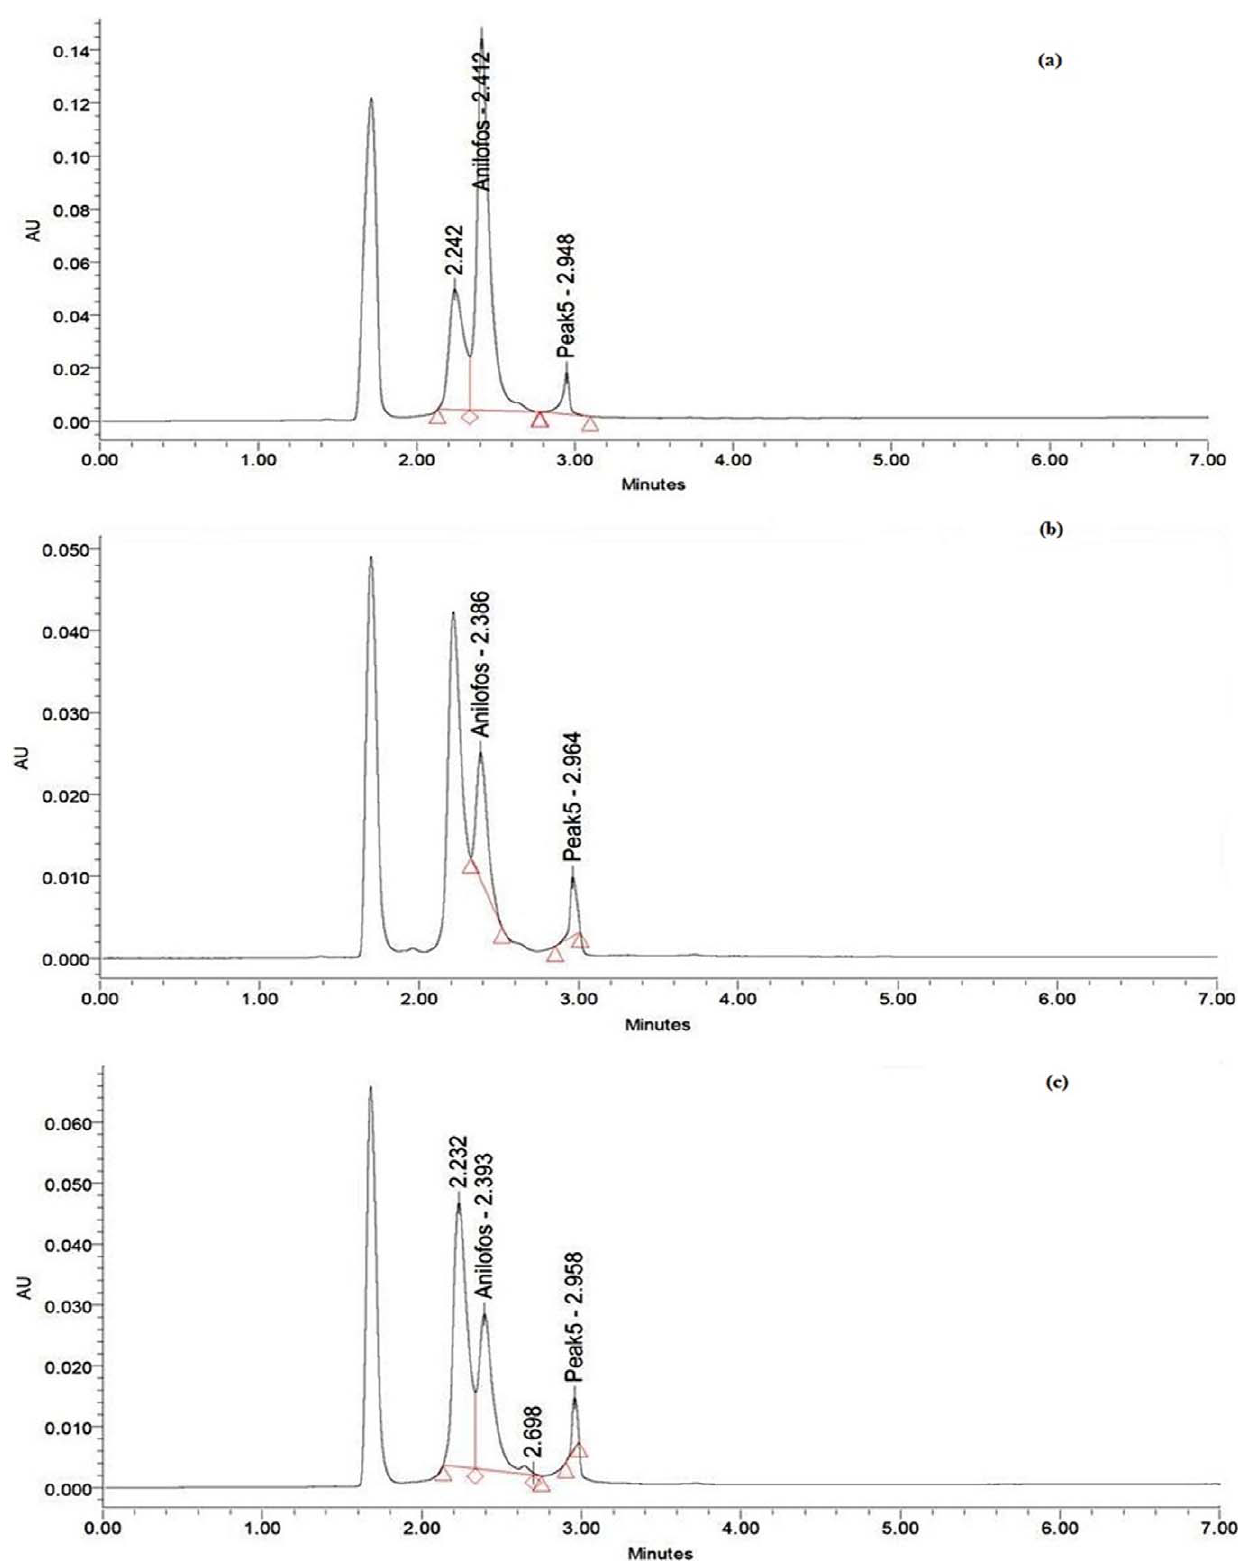
Figure 6. HPLC chromatogram showing the peaks of (a) standard anilofos, (b) cell extract and (c) supernatant. First large peak in the HPLC chromatogram represents solvent used to dissolve extracted anilofos.